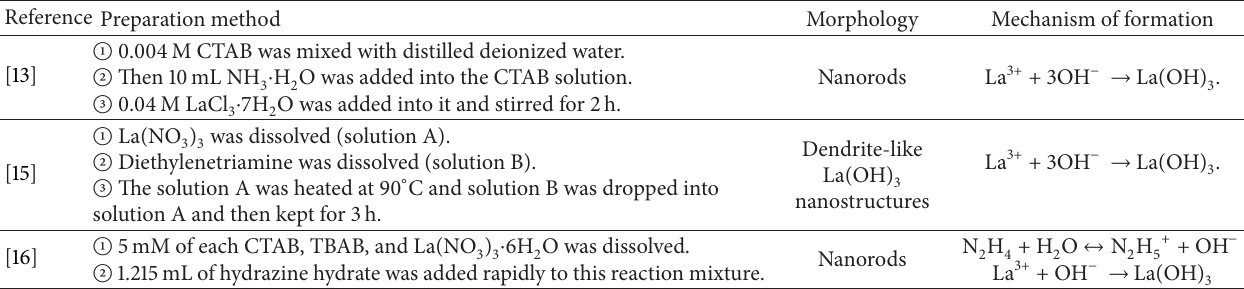
nanostructure by 3